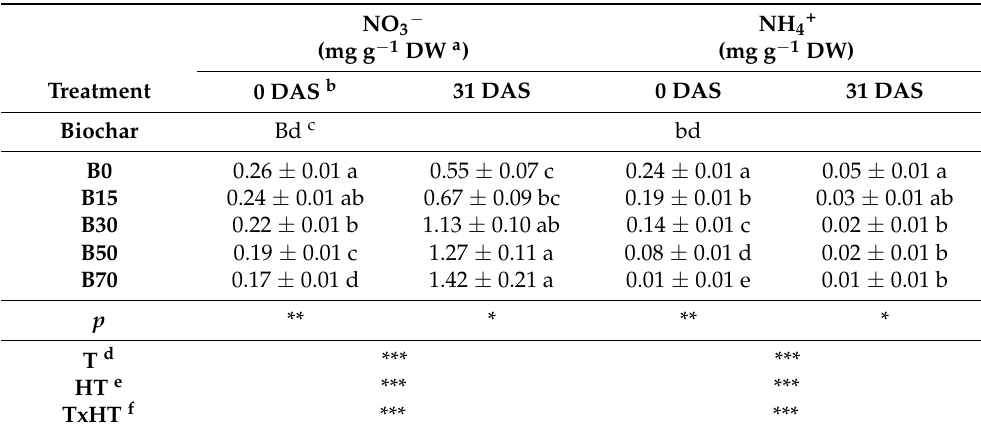
Table 5. NO 3 − and NH 4+ contents in biochar:peat mixtures at the beginning (0 DAS) and the end of the experiment (31